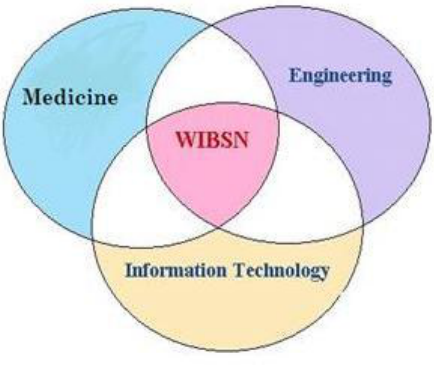
Figure 1. Interdisciplinary sciences for the future of